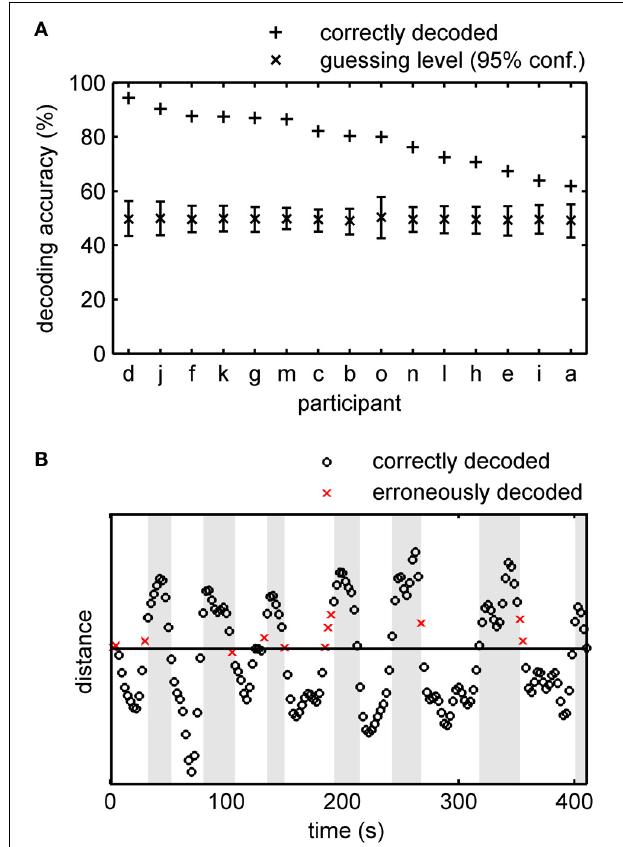
FIGURE 3 | Accuracy of offline tracking. (A) Single subject decoding accuracy obtained by a leave-one-run-out cross-validation. On average 79.2% (SE: 2.6%) of the acquisition time the decoded percept was correct. For each participant the mean guessing level as determined by permutation testing is approximately 50% and the fraction of correctly decoded perceptual states exceeds the 95% confidence interval of the guessing level. Participants are sorted by performance. (B) Time course of the distance (arbitrary unit) of the data points in classification space to the separating hyperplane constructed by a SVM for participant d , Run 5 (92.7% accuracy). White background signifies intervals in which the participant indicated perceiving the integrated object and gray background signifies intervals with line percepts. EPI-volumes for which the conscious percept was correctly identified are shown as circles, incorrectly identified percepts as crosses.